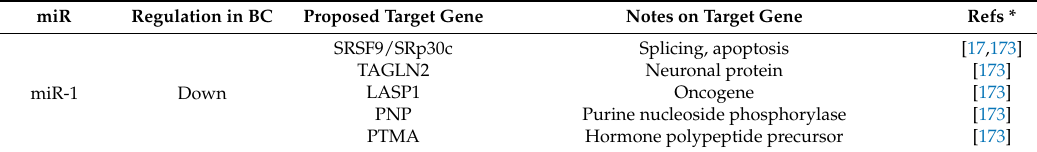
Table 3. List of microRNA (miR) with an established role in BC and at least one recognized target gene. miR are ordered according to their first digit, then second digit, and so on; notes are taken from the OMIM database [59] and describe either the molecular or the cellular function of the target